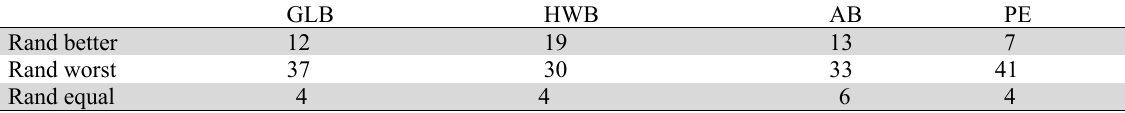
Comparison of the lower bounding methods with Rand – best (minimum)